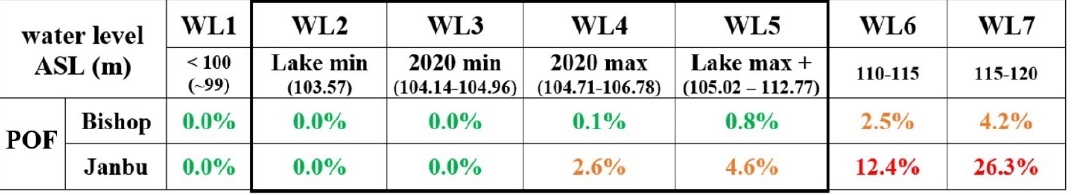
Figure 9. Probability of failure (POF) by Bishop and Janbu simplified methods for different modeled water